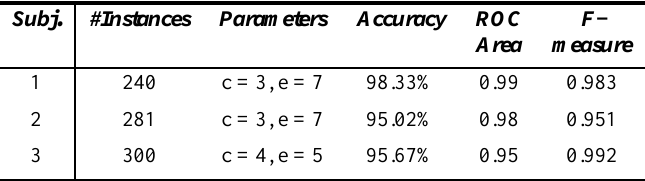
Table 4: Classification performance on Full